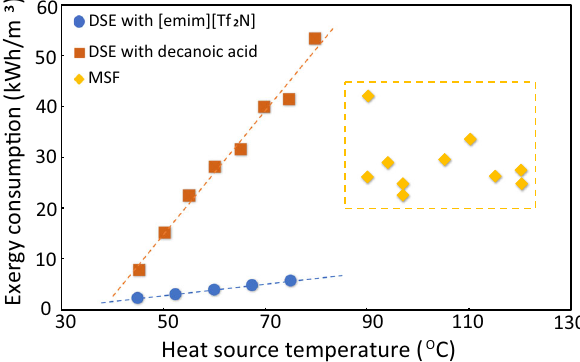
Fig. 5 Exergy consumption as a function of heat source temperature. Comparison of exergy consumption of directional solvent extraction (DSE) using [emim][Tf 2 N] and decanoic acid and multi-stage fl ash (MSF). Propagated from the data uncertainty from Fig. 3, the calculated uncertainty of the blue data points ranges from 20% (at 45 °C) to 17% (75